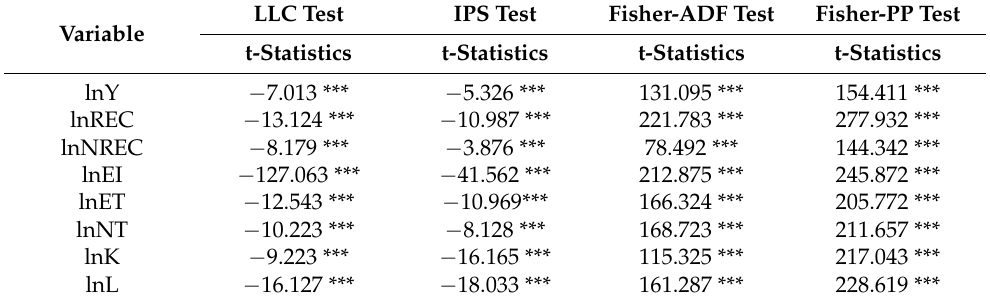
Table 3. Single integer